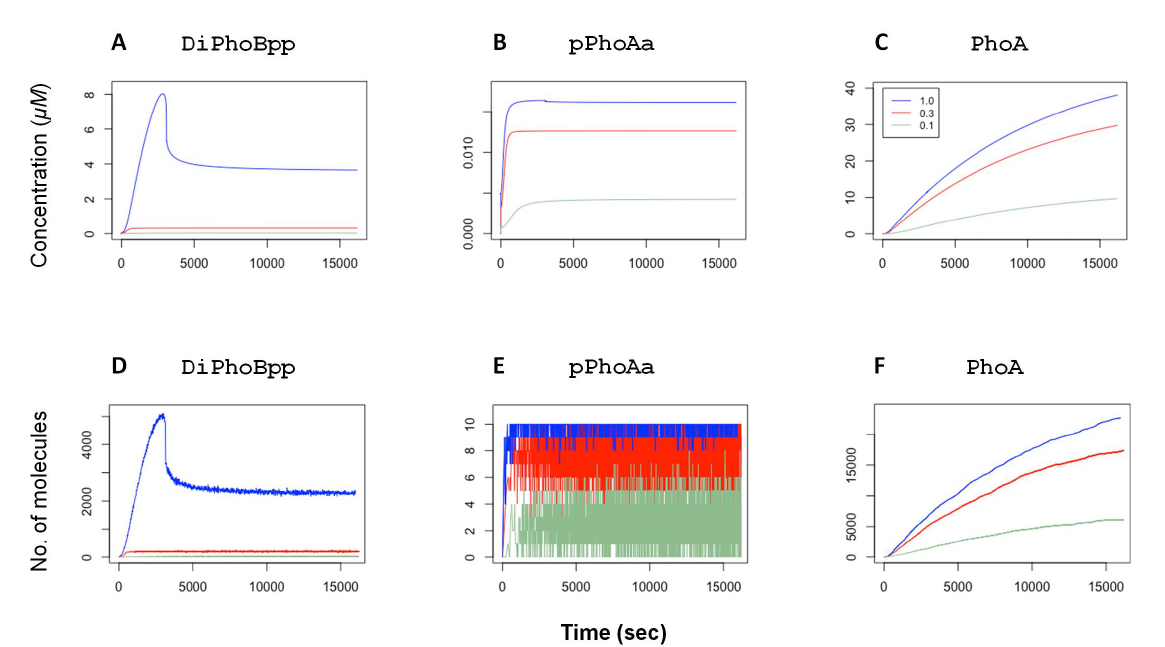
Figure 2. Top. Deterministic time-series plots with ordinary differential equation simulations display the response to the variations in external P i concentrations for ( A ) DiPhoBpp , ( B ) pPhoAa and ( C ) PhoA . The external P i concentration is given with the fold-change fc . A higher external P i concentration is modelled with a smaller factor and vice versa. The different fc values are colour-coded in the legend. Bottom. Stochastic time series plots with different external P i concentrations for ( D ) DiPhoBpp , ( E ) pPhoAa and ( F ) PhoA . The colour codes of the curves are as in the top row. As in the deterministic simulations, a higher external P i concentration is given with a smaller factor fc , colour-coded in the legend. The number of promoters, given by 10 plasmids, gives rise to a greater noise in the number of active promoters pPhoAa in comparison to those in active transcription factor DiPhoBpp and PhoA . PhoA quantifies the